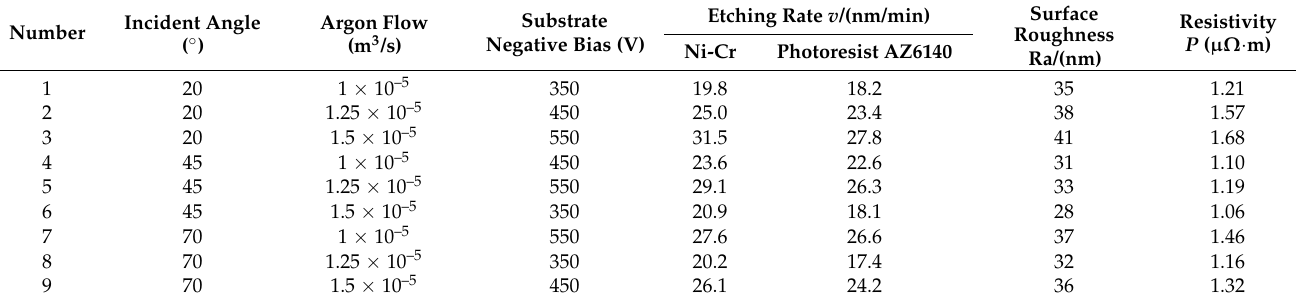
Table 8. Ion beam etching orthogonal test design and